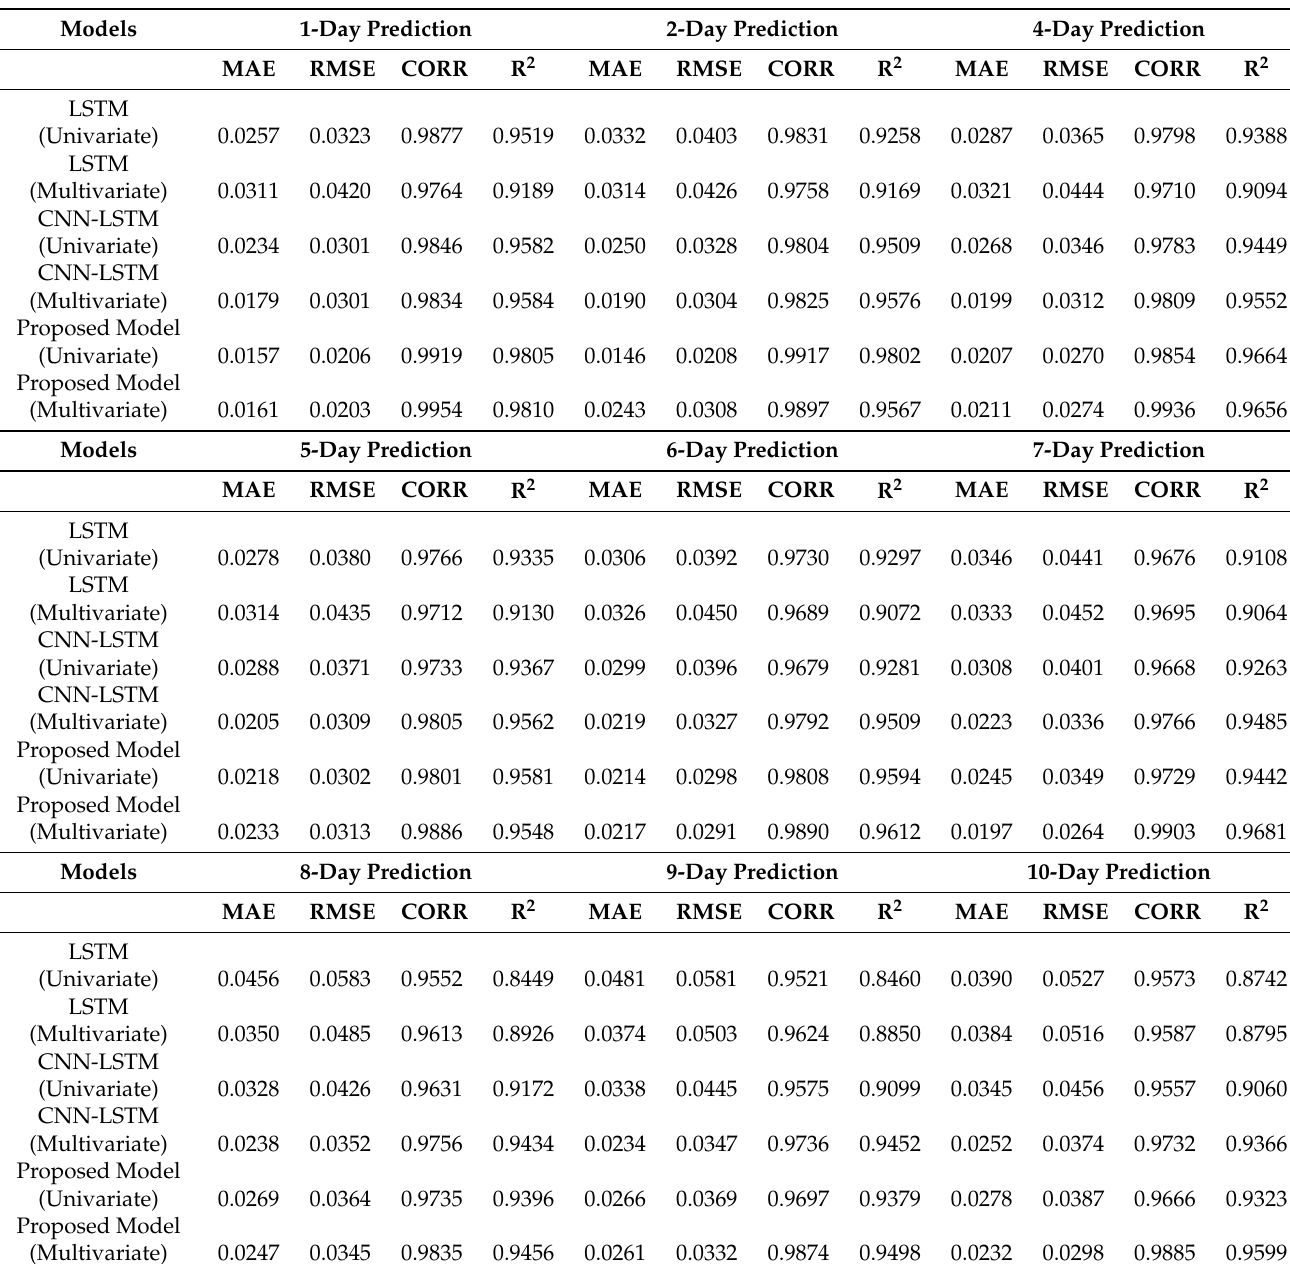
Table 1. Comparison of the performance results for LSTM-based models for 1-day to 10-day predic-